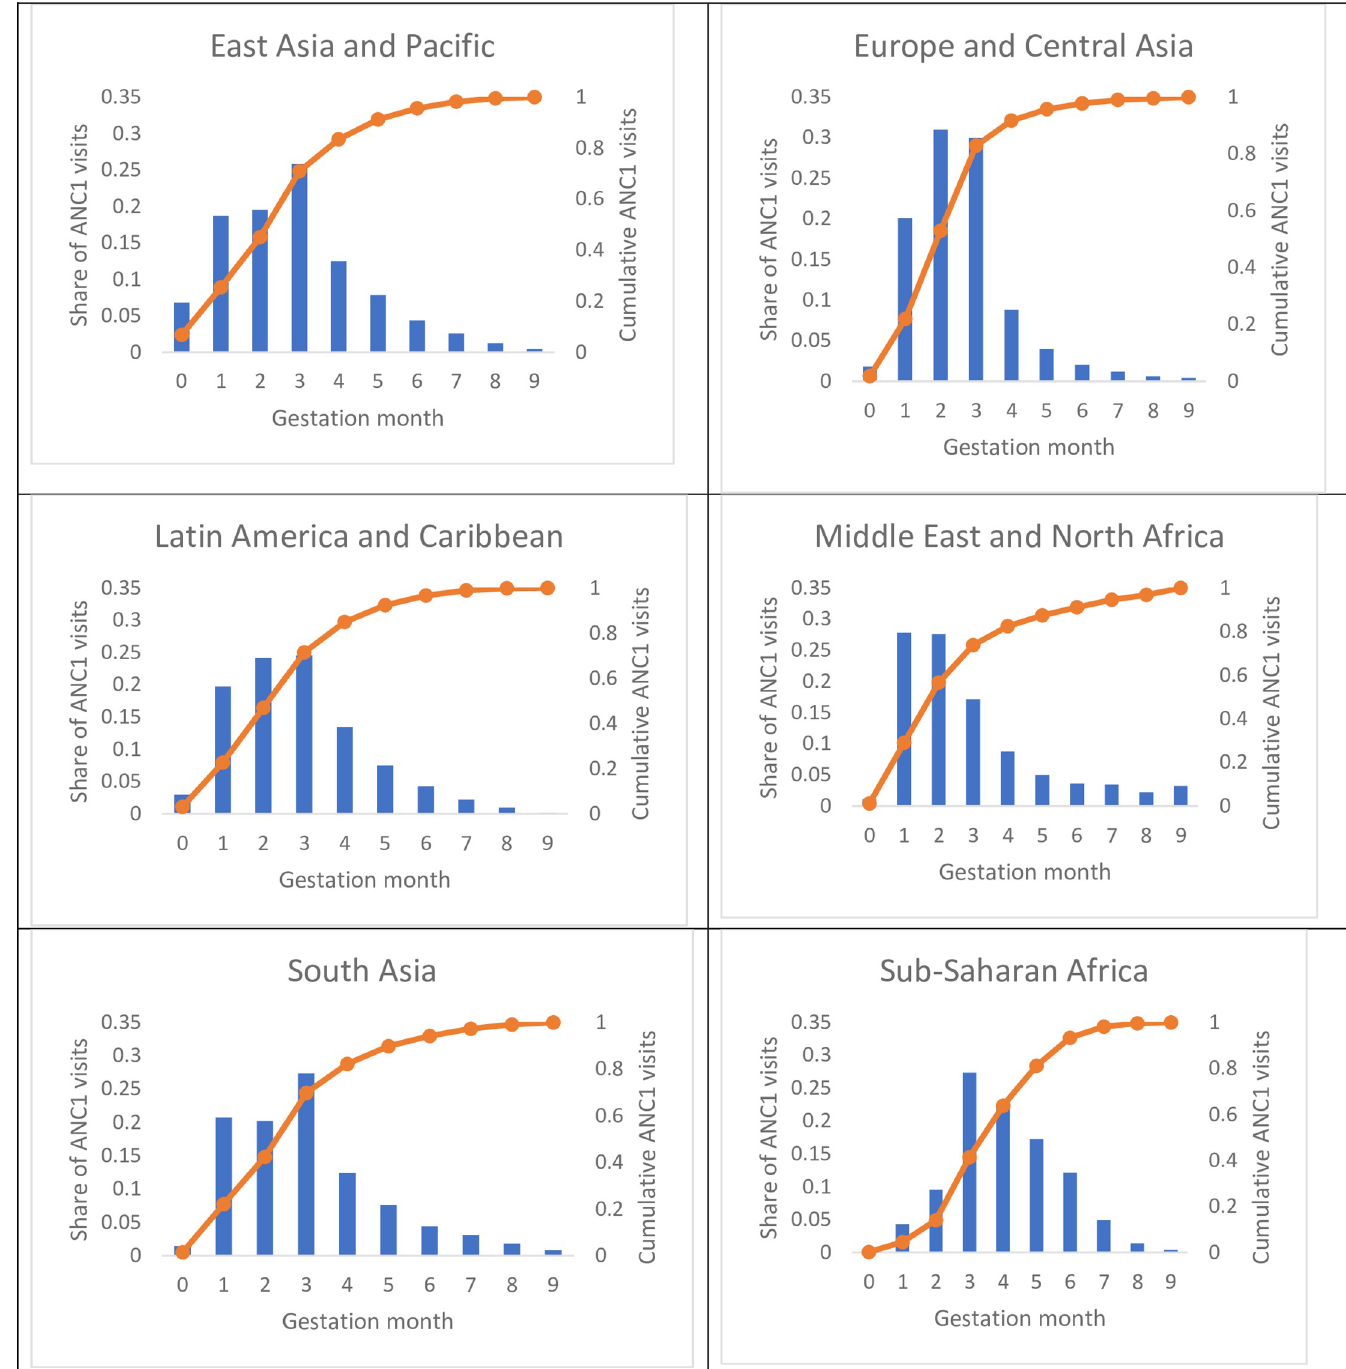
Fig 1. ANC1 timing by gestation month by geographic